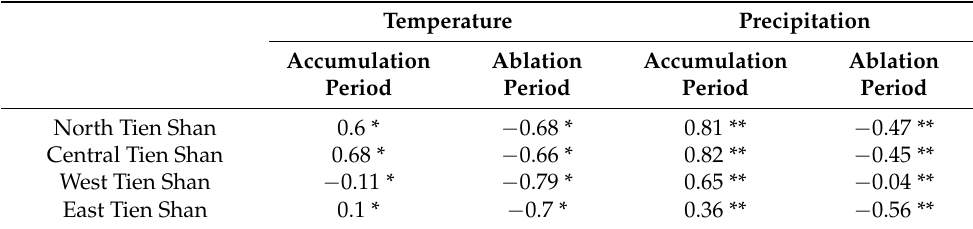
Table 2. Pearson correlation coefficient between the temperature/precipitation and the mass balance in the subregions. Temperature Precipitation Accumulation Ablation Accumulation Ablation Period Period Period Period North Tien Shan 0.6 * − 0.68 * 0.81 ** − 0.47 ** Central Tien Shan 0.68 * − 0.66 * 0.82 ** − 0.45 ** West Tien Shan − 0.11 * − 0.79 * 0.65 ** − 0.04 ** East Tien Shan 0.1 * − 0.7 * 0.36 ** − 0.56